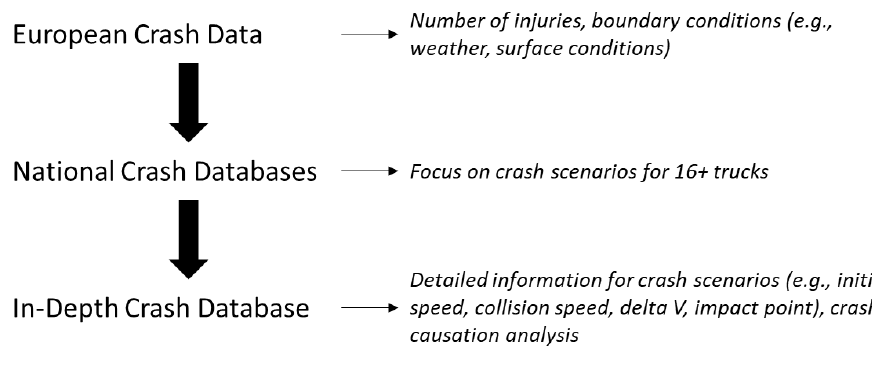
Figure 1. Overview of analysis approach .